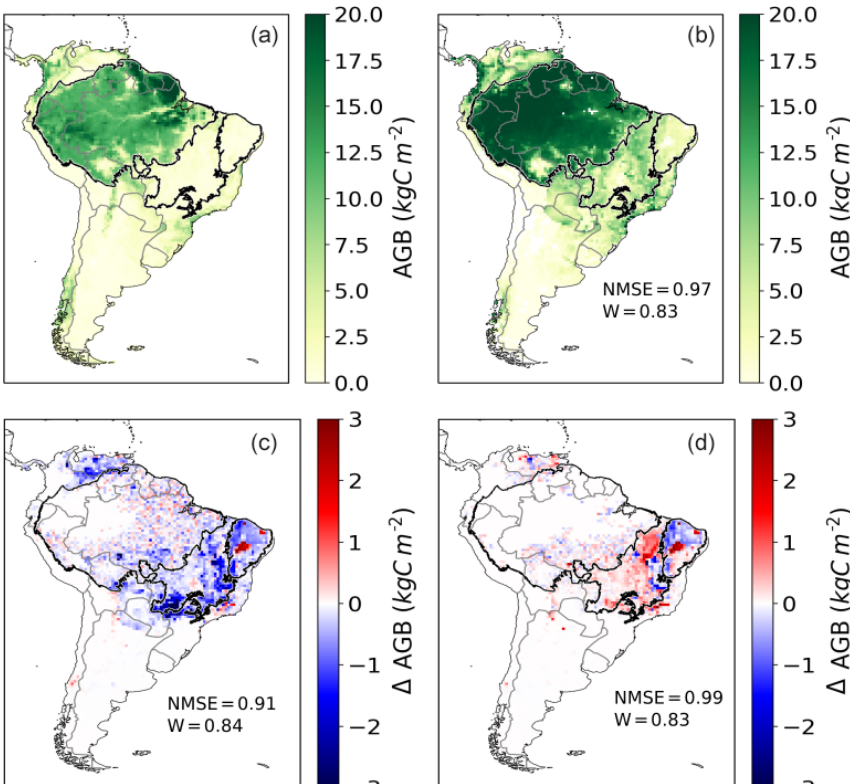
Figure 7. Annual aboveground biomass (AGB) of trees over a mean from 2005 to 2015 in kgCm − 2 . (a) Avitabile evaluation data. (b) Sim- ulated AGB by LPJmL4-SPITFIRE in the NI orig version. (c) Difference between VPD optim and NI orig . (d) Difference between NI optim and NI orig . Red (blue) color indicates a larger (smaller) biomass after the